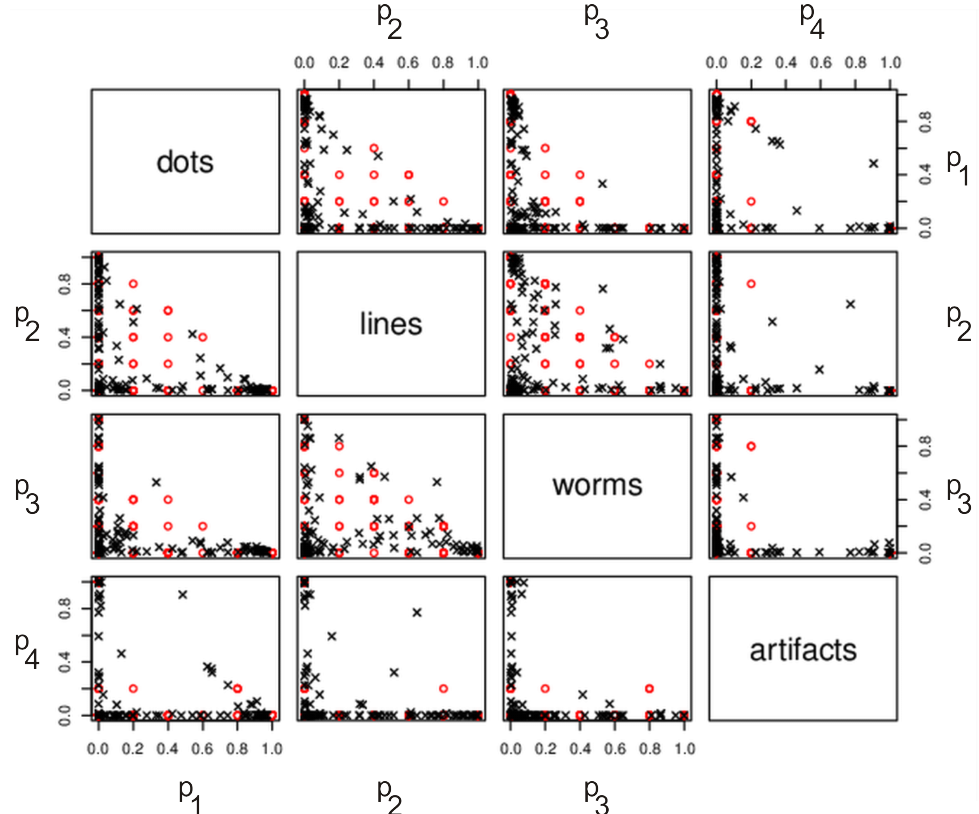
Figure 5. The pairs plot showing the bivariate relationships between all pairs of variables in one of the validation data sets. The pairs plot is represented as scatterplots between all pairs of these variables. In the first line, there is a scatter plot of spots and tracks, then one of spots and worms, and then one of spots and artefacts. The second row presents tracks and spots (symmetric to the first), tracks and worms, and so on. For a detailed description of the pairs plot, see [48]. Red dots are judge-labeled while black crosses are predicted values. Predictions were performed using a neural network with the VGG16 input layer. Values on the axis are the coordinates of vector p (see Equation (2)). For example, p 1 = 1 means that all judges voted for dot and p 2 = 0.5 means that half of the judges voted for